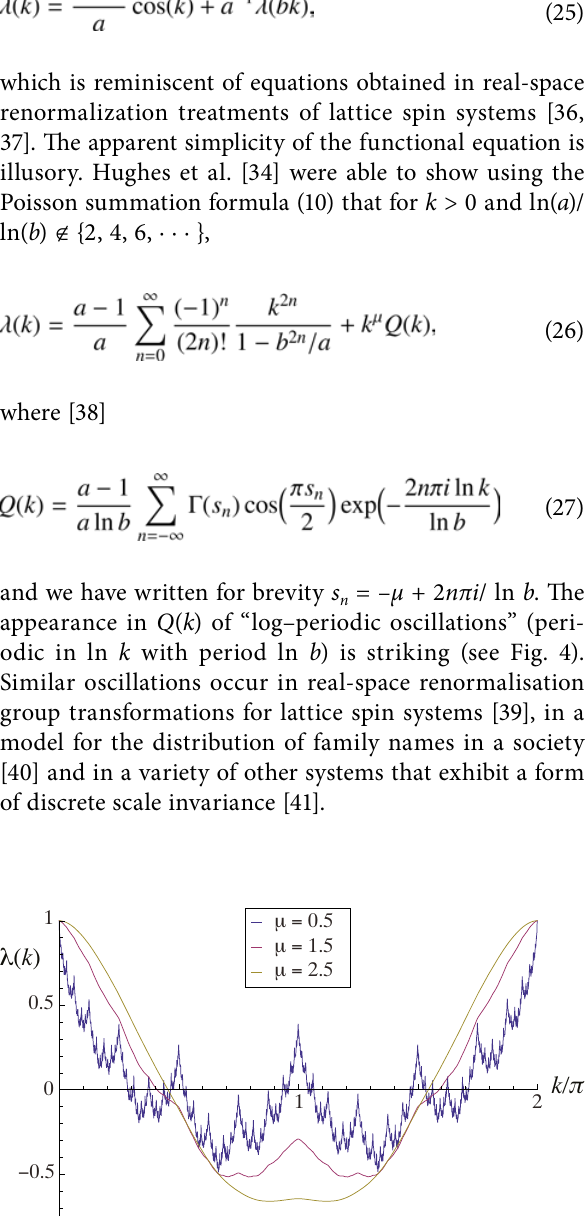
Figure 4. The structure function (24) of the Weierstrass random walk step probability density function (23). In each case, b = 2, and we choose a values so that so that µ = ln( a )/ ln( b ) takes the val- ues 0.5 [blue (most irregular) curve], 1.5 (red curve) and 2.5 (gold